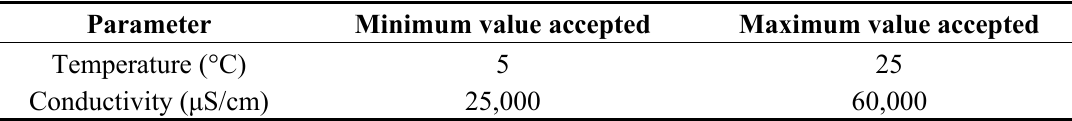
Table 2. Thresholds applied to physical parameters of temperature and